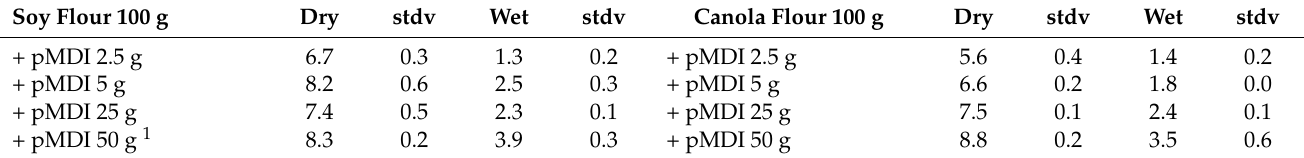
Table 2. ABES shear strength (MPa) of 25% soy or canola flour adhesives with increasing amounts of pMDI (in g/100 g of soy or canola flour) under dry and wet